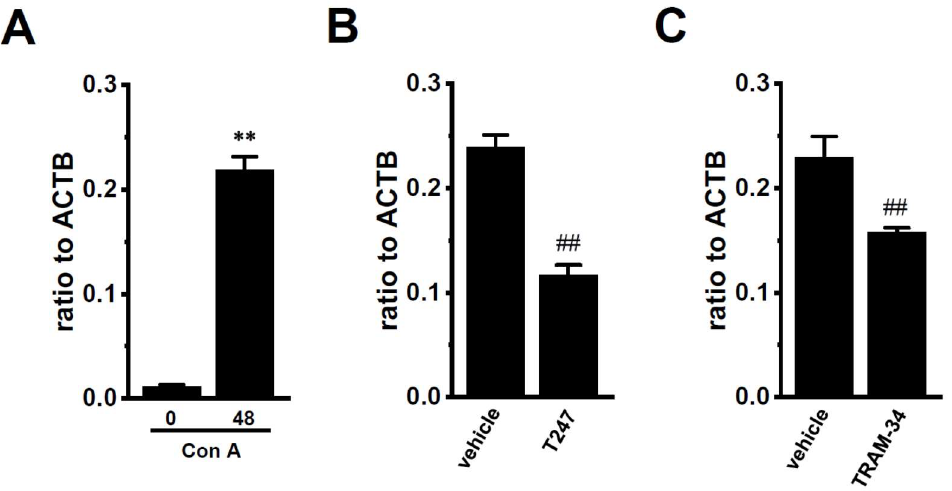
Figure 7. Effects of treatments with 1 µ M T247 for 24 h and 1 µ M TRAM-34 for 12 h on the gene expression of CD25 in Con A-stimulated mouse thymocytes. ( A ) Real-time PCR assay for CD25 in Con A-stimulated mouse thymocytes for 0 or 48 h. ( B , C ) Real-time PCR assay for CD25 in Con A-stimulated mouse thymocytes that were treated with 1 µ M T247 for 24 h ( B ) and 1 µ M TRAM-34 for 12 h ( C ). Expression levels were expressed as a ratio to ACTB. The results are expressed as means ± SEM. **: p < 0.01 vs. Con A-stimulated for 0 h. ## : p < 0.01 vs. vehicle control.